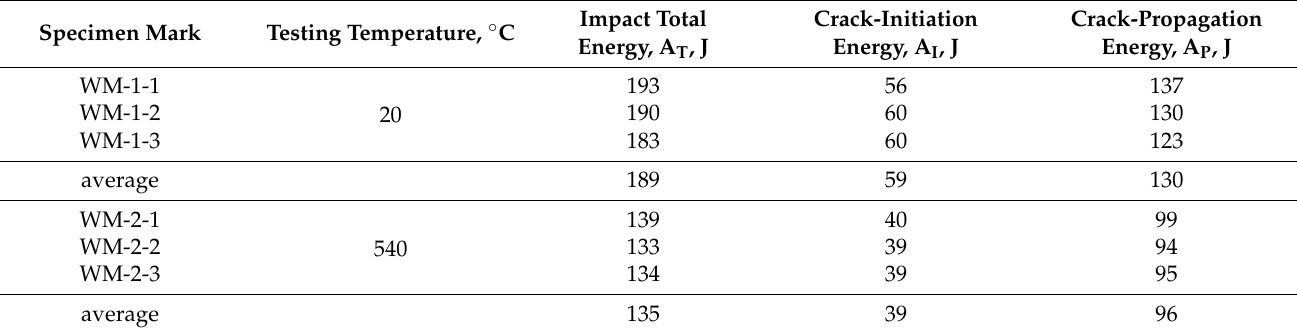
Table 8. Results of impact testing for A387 Gr. B/WM [13].